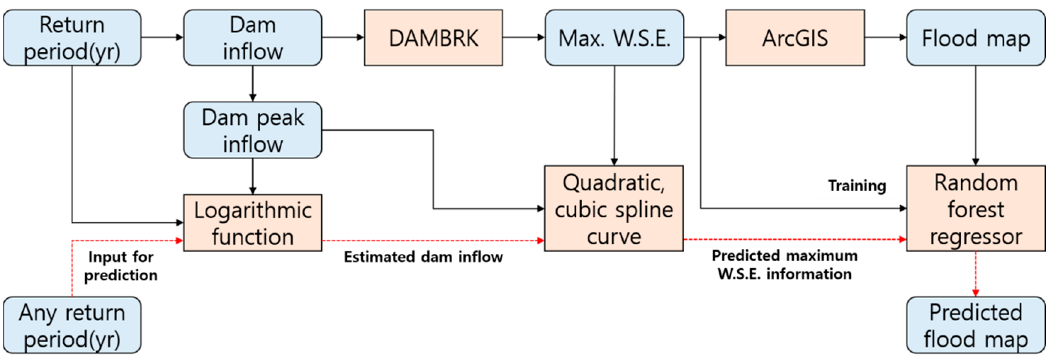
Figure 1. Flow chart for flood map prediction.